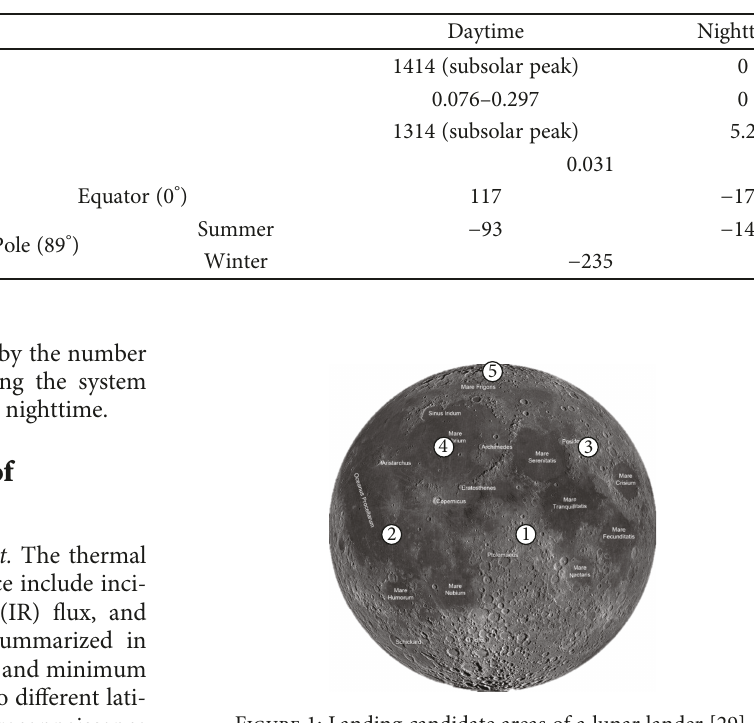
Table 1: Thermal environment conditions on the lunar surface [8].